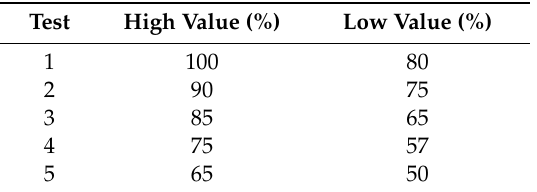
Table 3. Five combinations of motor commands in the zigzag test.